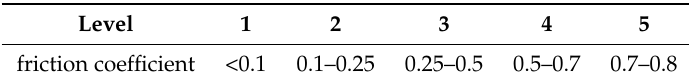
Table 5. Friction coefficient and